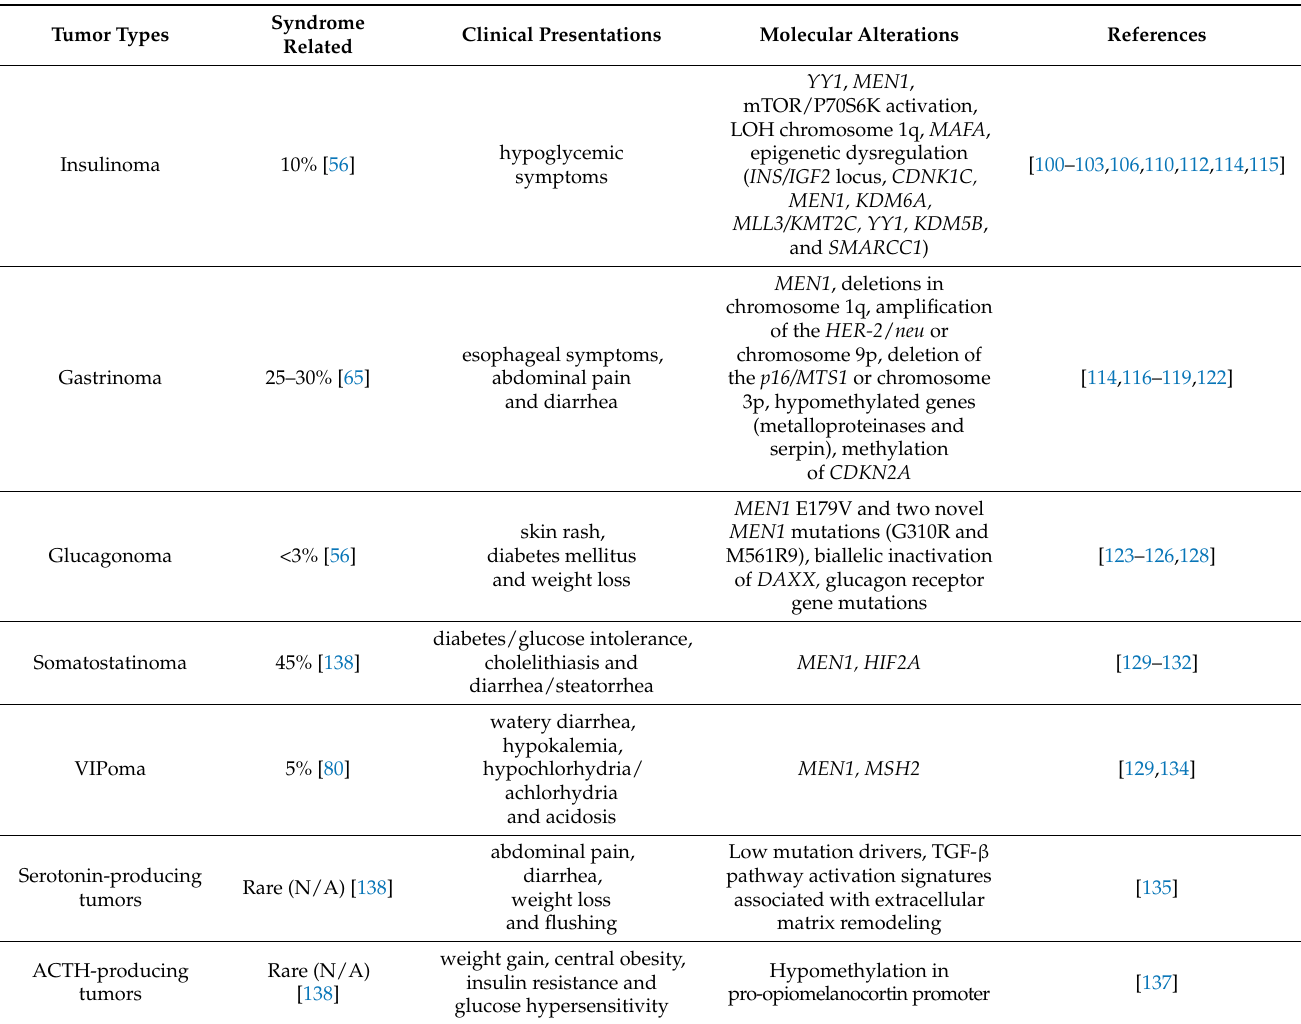
Table 2. The reported molecular alterations of each subgroup of functioning PanNENs with clinical presentations and frequency of MEN1-associated syndrome. LOH: loss of heterozygosity; VIP: vasoactive intestinal peptide; ACTH: adrenocorticotrophic